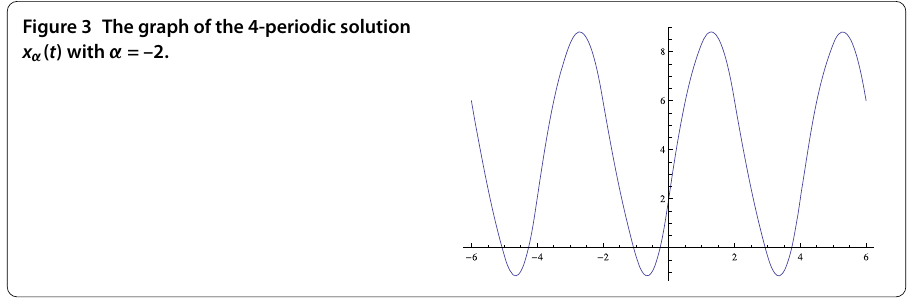
Figure 3 The graph of the 4-periodic solution x α ( t ) with α =